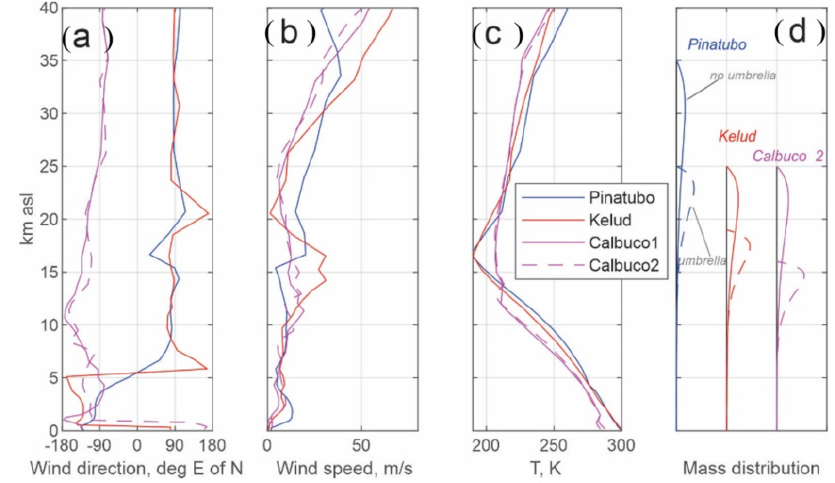
Figure 3. Wind direction ( a ), speed ( b ), and air temperature ( c ) as a function of altitude during the three eruptions studied. Vertical profiles for all eruptions are taken from the nearest node in the ERA5 data at times near the eruption start: 06:00 UTC for Pinatubo; 16:00 UTC for Kelud; 19:00 UTC on 22 April for Calbuco phase 1; and 06:00 UTC on 23 April 2015 for Calbuco phase 2. Wind direction is the direction from which the wind is blowing, in degrees clockwise from true north. “Calbuco1” and “Calbuco2” refer to phase 1 and 2 of the Calbuco eruption. ( d ) Vertical distribution of mass used in models of Pinatubo ( left, blue ), Kelud ( center, red ), and Calbuco phase 2 ( right, magenta ). Solid and dashed lines give mass distributions for the non-umbrella and umbrella simulations, respectively.